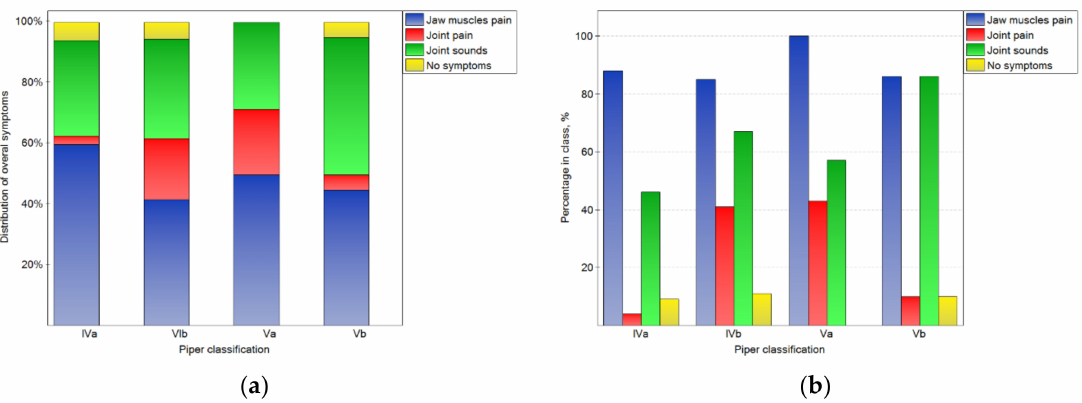
Figure 2. Impact of the Piper classification on the chosen overall symptoms related to TMJ functioning: the distribution of symptoms among the classes ( a ), and the percentage of symptoms in the number of noted cases for the particular classes ( b ).